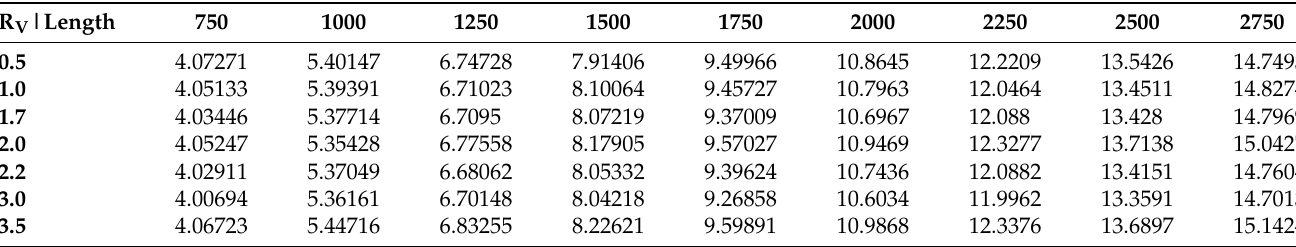
Table A8. Execution times in milliseconds on CPU with cable structure for 40,000 time-steps (2.0 s); R V on the Left and number of cells (length) on the Top